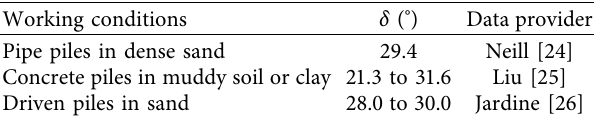
Table 2: Suggested value of the friction angle of pile-soil interface δ